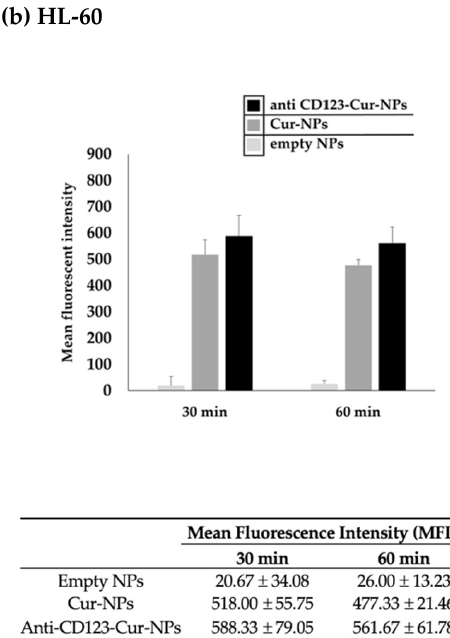
Figure 4. Cellular uptake of anti-CD123-Cur-NPs or nontargeted Cur-NPs in KG-1a and HL-60 leukemia cell lines. KG-1a (CD123+) ( a ) and HL-60 (CD123-) ( b ) cells were incubated with anti-CD123-Cur-NPs or Cur-NPs for 30 and 60 min, and fluorescent intensity was determined through flow cytometry. The experimental data were collected in three independent experiments, and the results were determined using one-way ANOVA. The statistical differences were considered significant at ** p < 0.01.